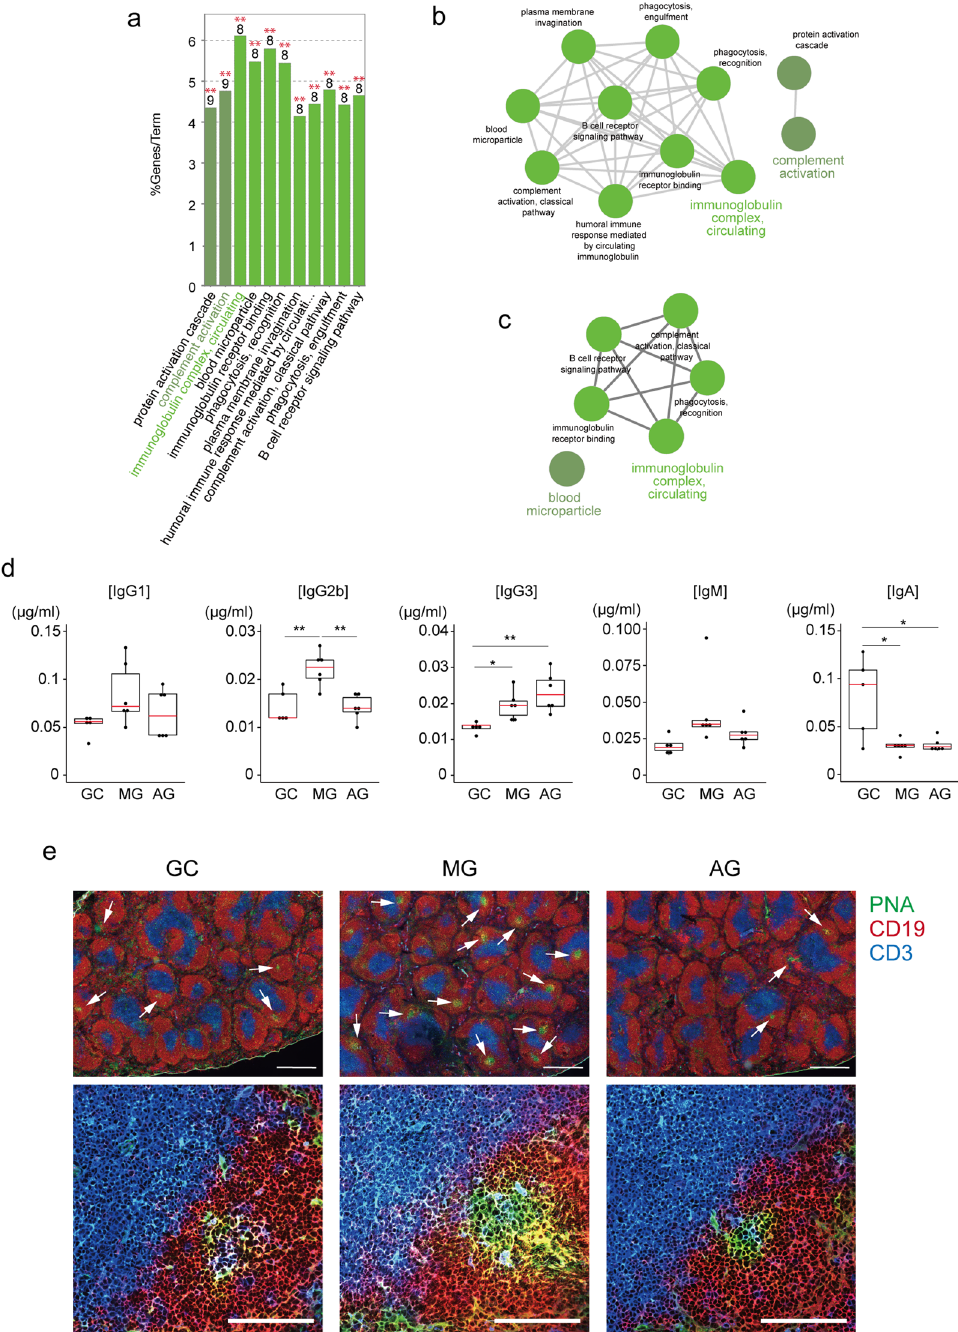
Figure 4. Disturbance of plasma immunoglobulin levels by spaceflight. ( a ) Gene ontology (GO) enrichment analysis of genes up-regulated in the spleens of MG compared to GC mice. GO terms and percentage of the down-regulated genes among total termed genes are shown. Top number of each bar indicates the number of reduced genes in each term. ** P < 0.01, Two-side hypergeometric test corrected with Bonferroni step down. ( b ) Clusters of enriched GO terms for genes significantly up-regulated in the spleens of MG compared to GC mice. Each circle shows a GO term. A line between circles shows a correlation of two GO terms. ( c ) Clusters of enriched GO terms for genes significantly up-regulated in the spleens of AG compared to GC mice. Each circle shows a GO term. A line between circles shows a correlation of two GO terms. ( d ) Quantitative determination of immunoglobulin in sera from spaceflight and control mice as determined by ELISA. Both box plots and dot plots are shown in the figure. The red line indicates medians. GC: ground control mice; MG: mice flown in the ISS; AG: mice receiving 1 g by centrifugation in the ISS. ** P < 0.01, * P < 0.05 by two-tailed Student’s t-test. ( e ) Immunohistochemical staining of spleen sections with PNA (green), anti-CD19 (red), and anti-CD3e (blue). Scale bars indicate 100 µ m for lower panels and 500 µ m for upper panels. Arrows in upper panels indicate clear and large germinal centres in B cell follicles. Data represent a typical example of three independent